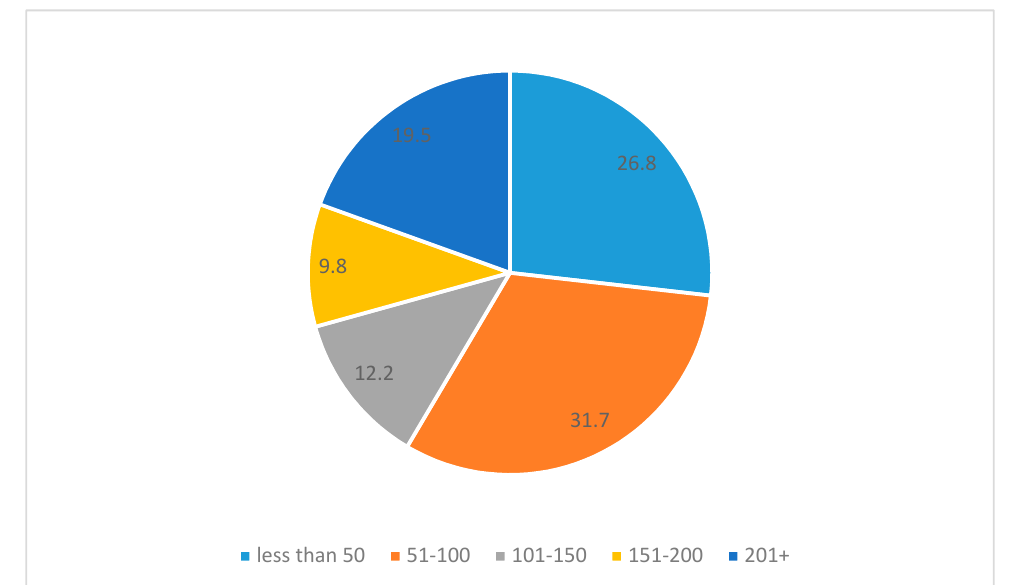
Figure 7. Portions of size categories of villages that disappeared in the Mravian and Silesian borderland with Poland and Austria [%].